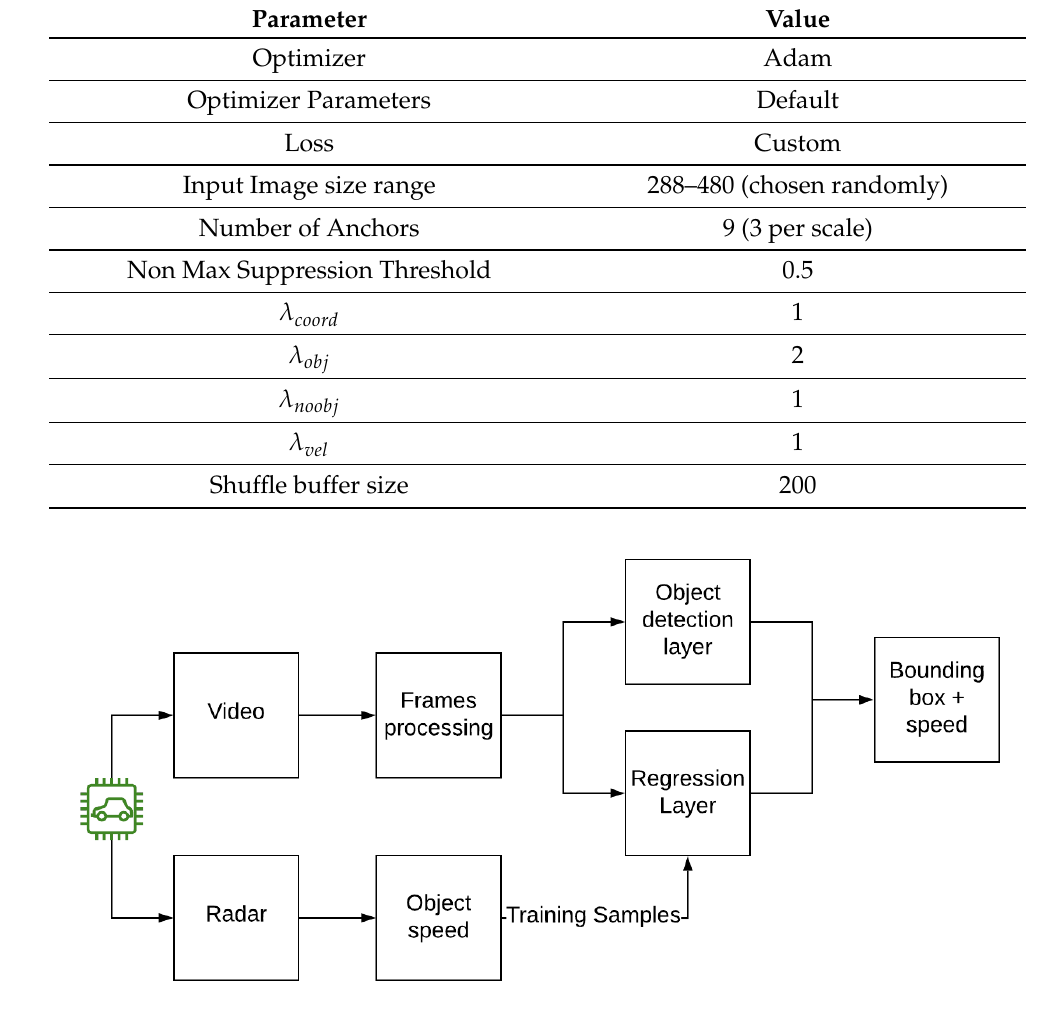
Figure 5. Yolo flow